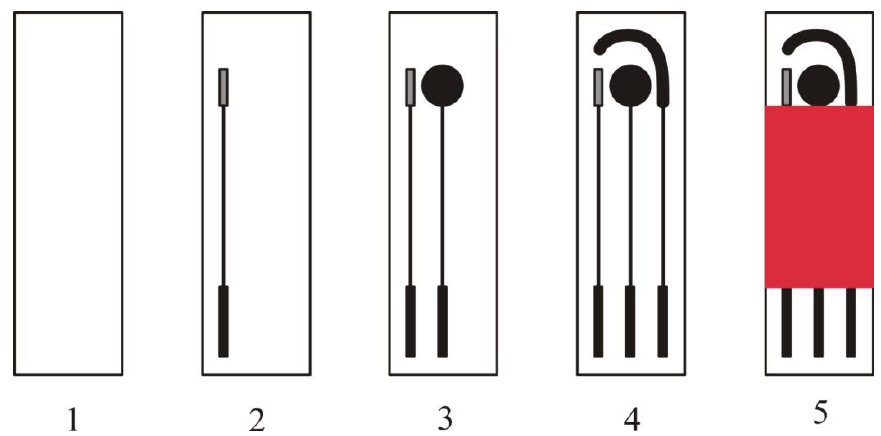
Figure 1. Fabrication of SPEs having three electrode system on chemically inert substrate ( 1 ). It involves screen printing of reference ( 2 ), working ( 3 ), and auxiliary electrode ( 4 ) on substrate followed by printing with protection paste ( 5 ).